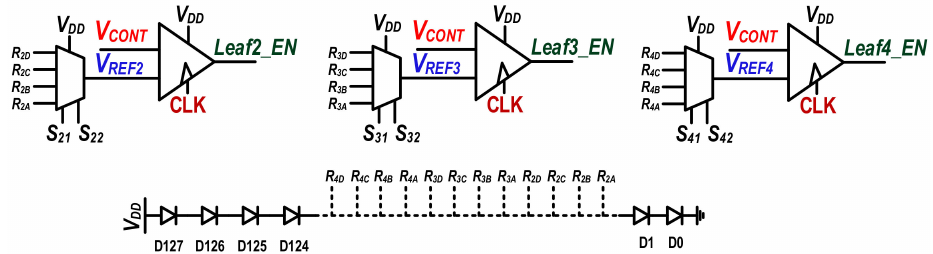
Figure 16. Reference comparison circuit for leaf control with V